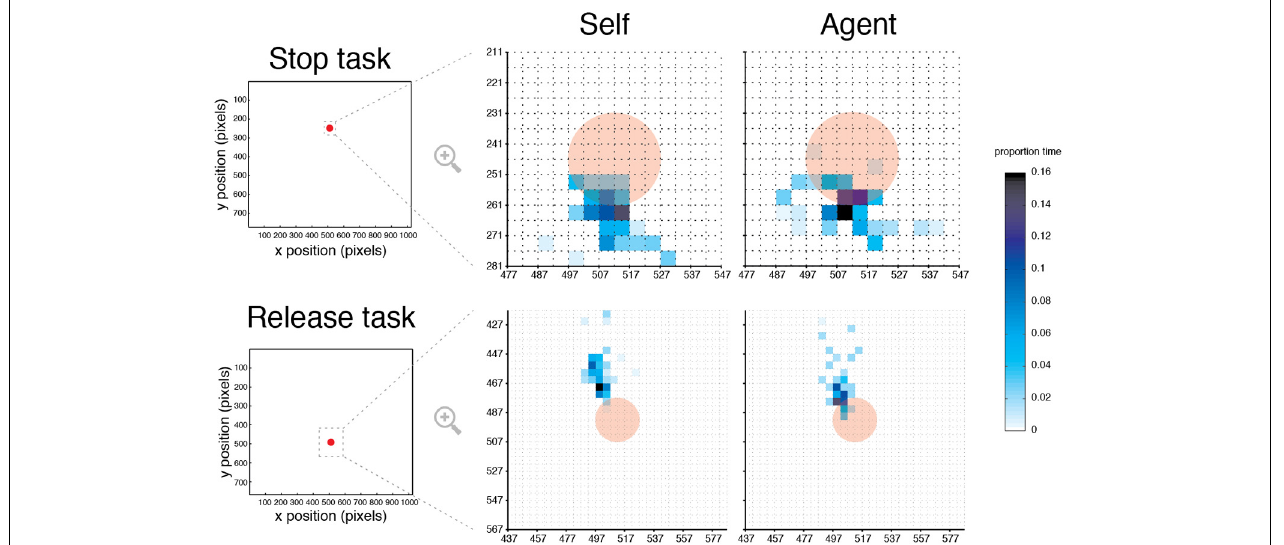
FIGURE 6 | Eye gaze position in Self and Agent conditions. Heat maps illustrating the mean fixation time as a percentage of block duration for a typical participant in the Stop and Release tasks, superimposed on the target (opaque red). For illustration, an area of